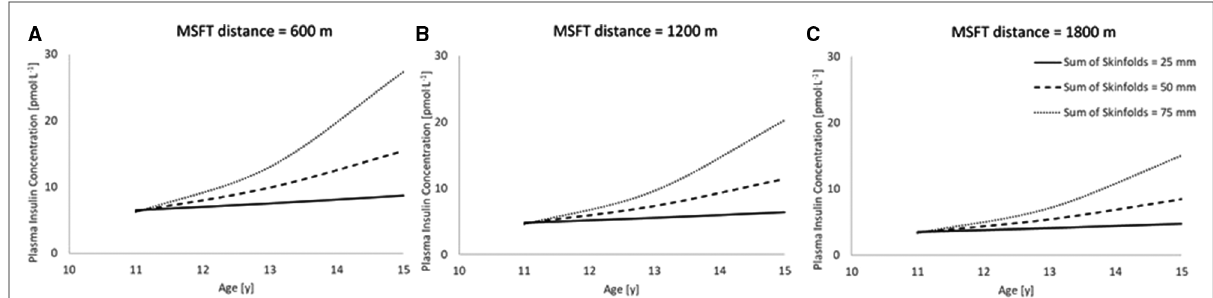
FIGURE 2 The combined model to best explain fasting plasma insulin concentration ( n =45). Modelled data for both distance run on MSFT and sum of skinfolds, where distance run on MSFT is 600 m ( Figure 2A ), 1,200 m ( Figure 2B ) and 1,800 m ( Figure 2C ). (Age * sum of skinfolds interaction, p =0.021; main effect of distance run on the MSFT, p =0.010). Hypothetical data displayed are mean±1 SD for both sum of skinfolds and MSFT.